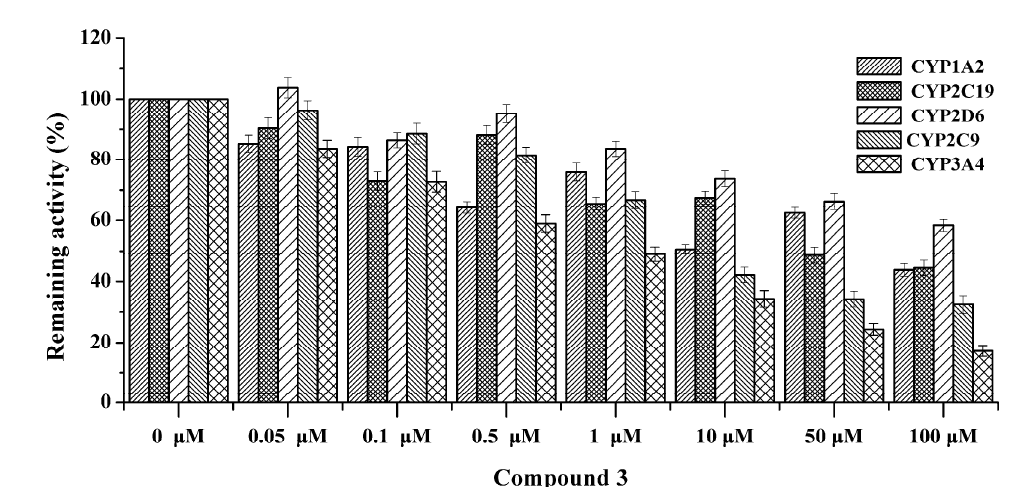
Figure 3. Inhibitory effects of compound 3 on CYP-catalyzed reactions. Each data point represents the mean of triplicate experiments and the standard deviation is shown as error bars.